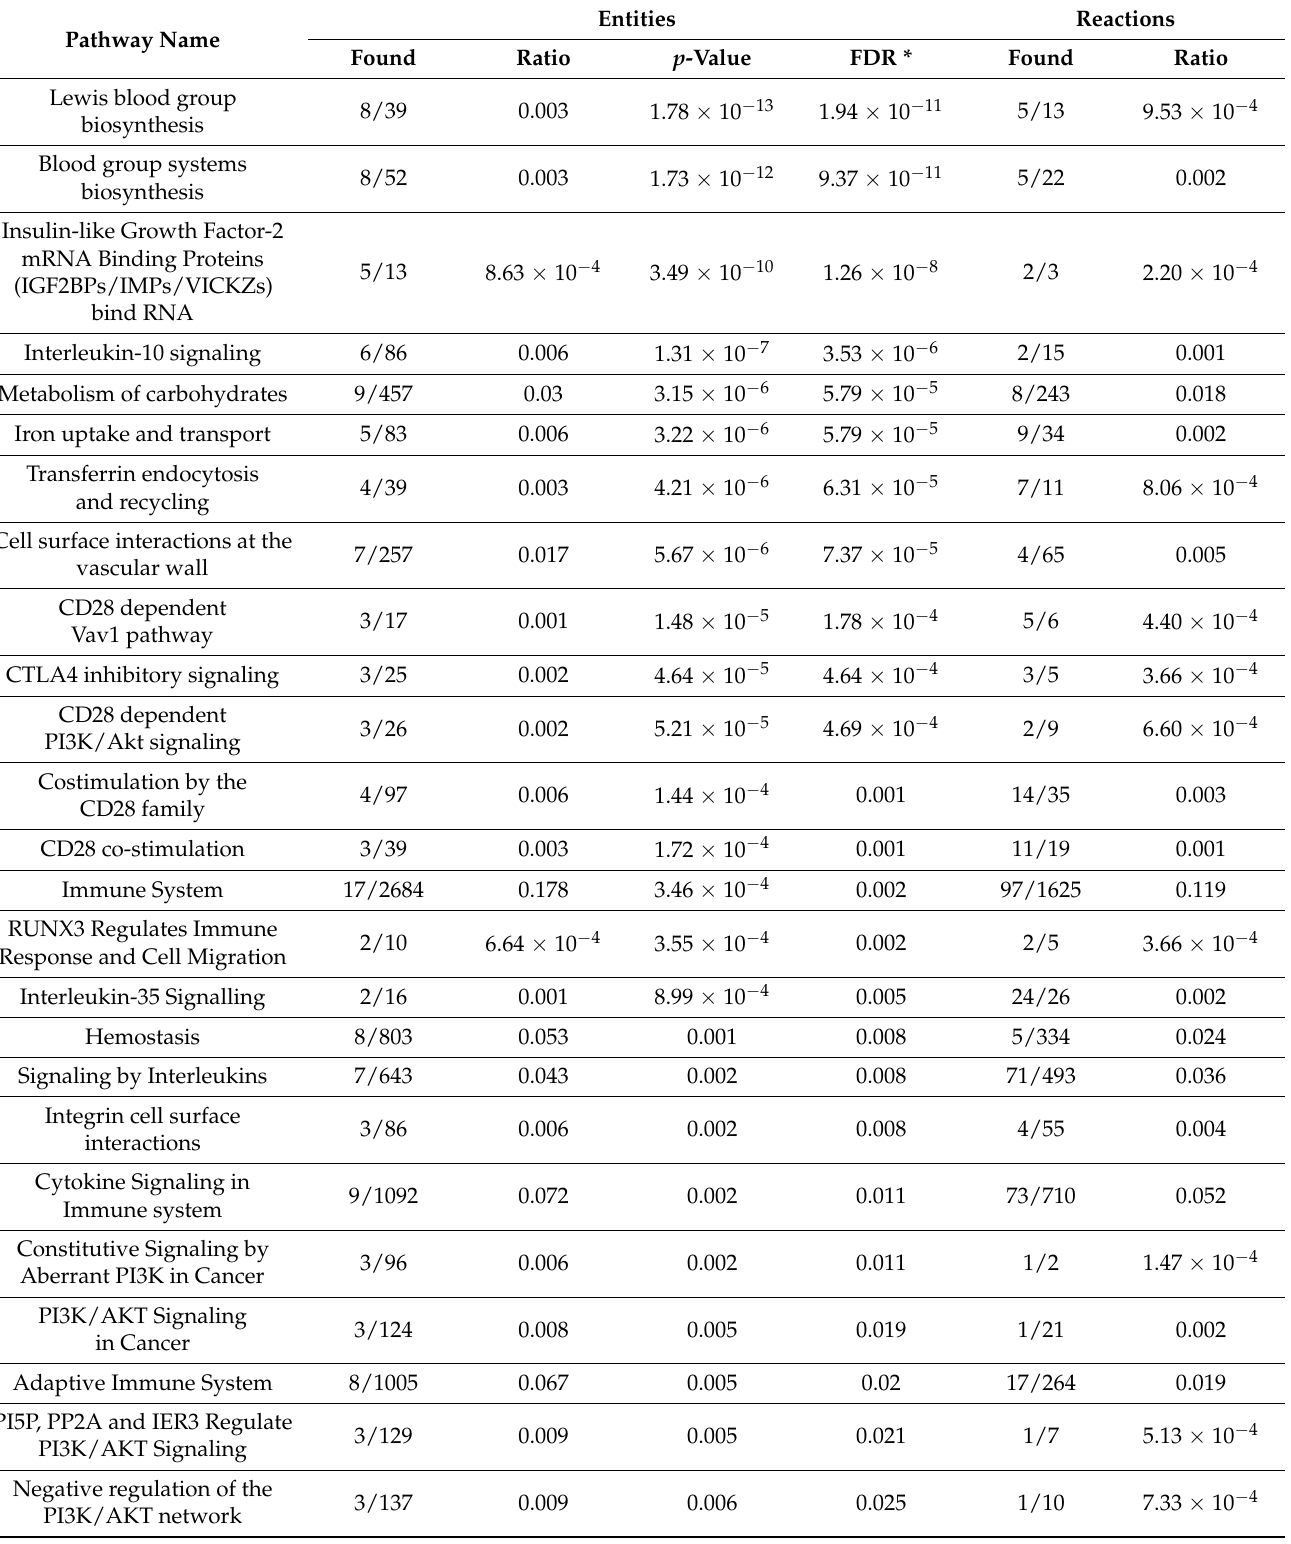
Table 1. Most significant pathways containing GTN genes. The 25 most relevant pathways sorted by p -value are